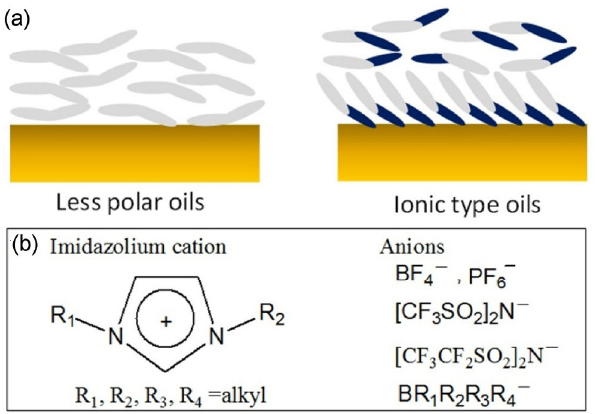
Fig. 3 (a) Diagram of lubricating oil interaction with frictional surface: from non/less polarity to high polarity oils. (b) Representative cation and anions that constitute ionic